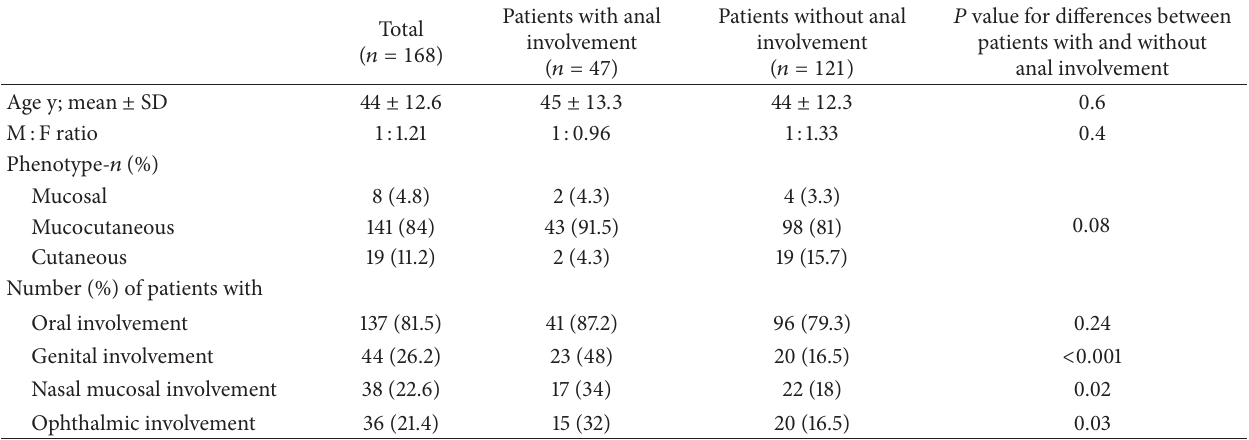
Table 1: Characteristics of pemphigus vulgaris patients with or without anal